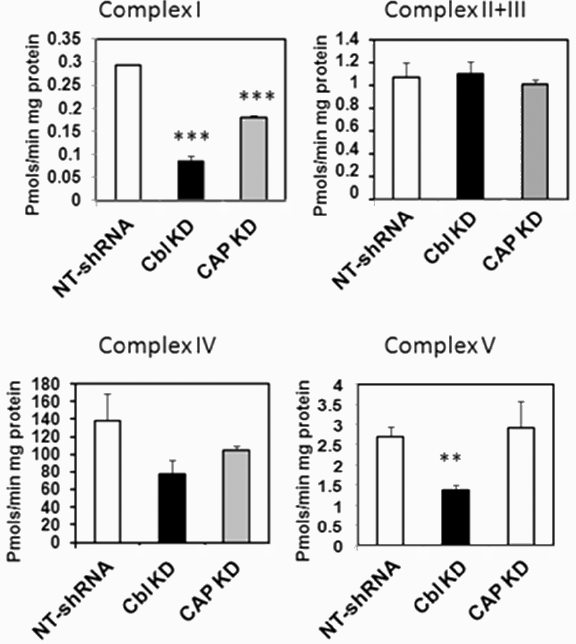
Figure 4. Mitochondrial respiratory complex I activity is reduced in CBL KD. Mitochondria were isolated by differential centrifugation. The activities of OXPHOS complexes were determined in vitro using spectrophotometric methods under non-limiting substrate conditions as explained in the section Materials and Methods. Data for each respiratory complex are expressed as nmol/min/mg or pmol/min/mg protein relative to NTshRNA-expressing cells. Graphs show mean ± SEM of 3 independent experiments. Statistical analysis: one-way ANOVA to NTshRNA-expressing cells. ** indicates p < 0.01; *** p < 0.001.